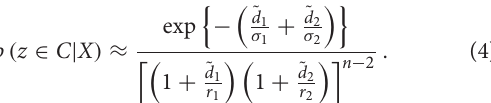
a small set of positive examples “+” of C . More precisely, let , . . . , x n , y n be a sequence of n examples of the X x 1 , y 1 = true concept C , already observed by the hearer, and (cid:1)(cid:9) (cid:8)(cid:0) (cid:1) (cid:0)